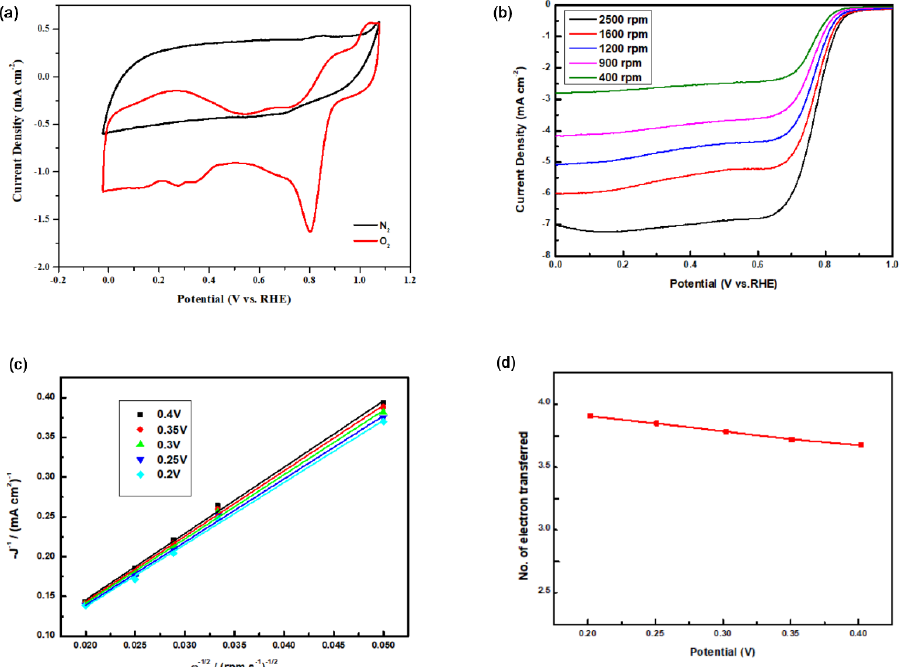
Figure 8. ( a ) CV-curves; ( b ) LSV curves obtained at various rpms; ( c ) K–L lines; ( d ) n-value vs. voltage of CoNC-1000A-900.